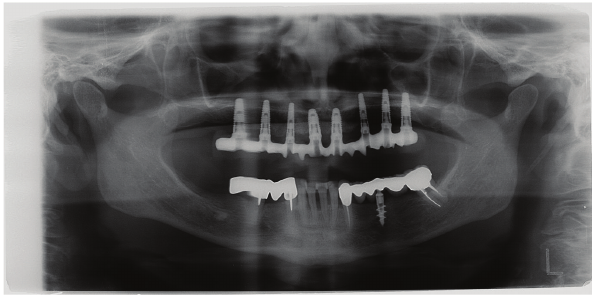
Figure 14: Final X-ray picture.